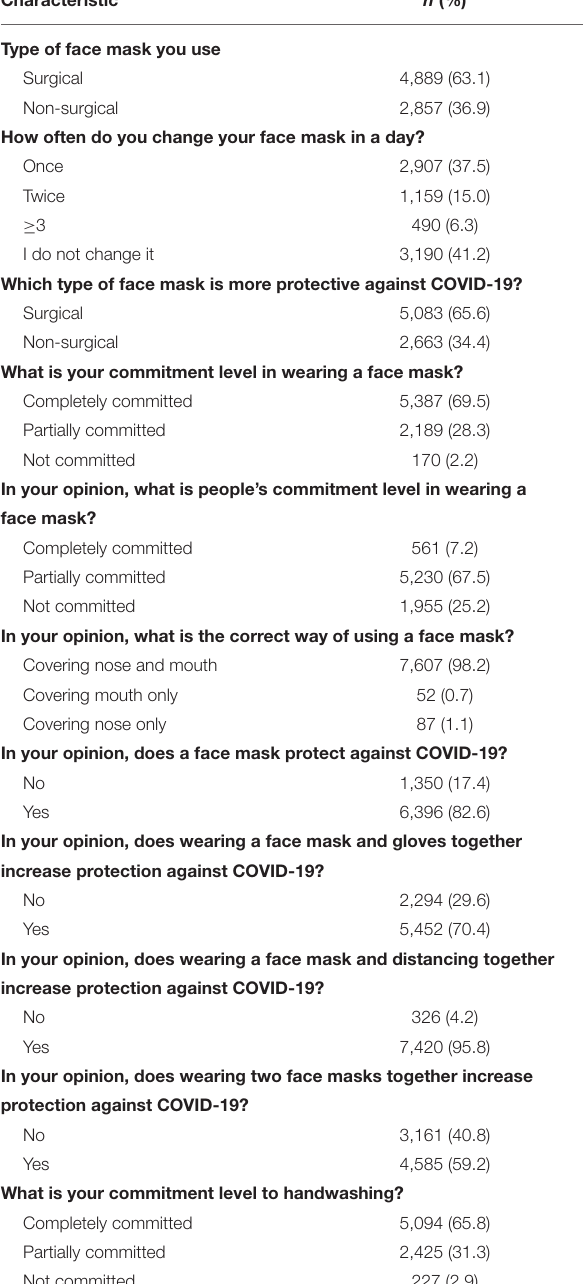
TABLE 2 | Commitment and attitudes of the study population toward various protective and precautionary behaviors ( n = 7,746).